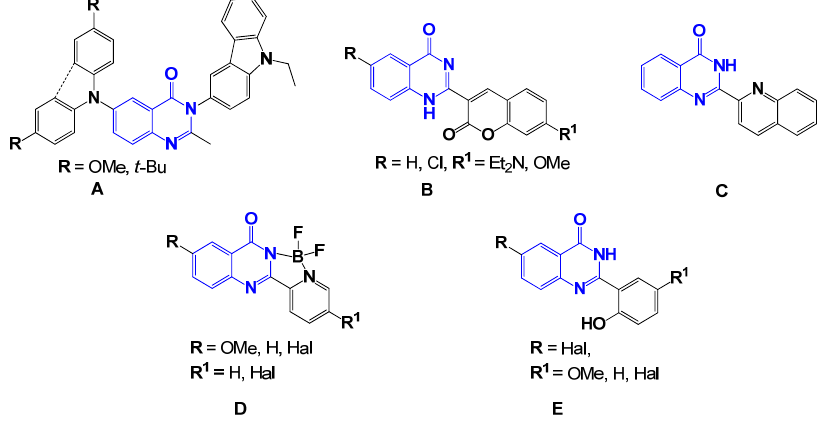
Figure 1. Representatives of quinazolin-4(3 H )-one-containing